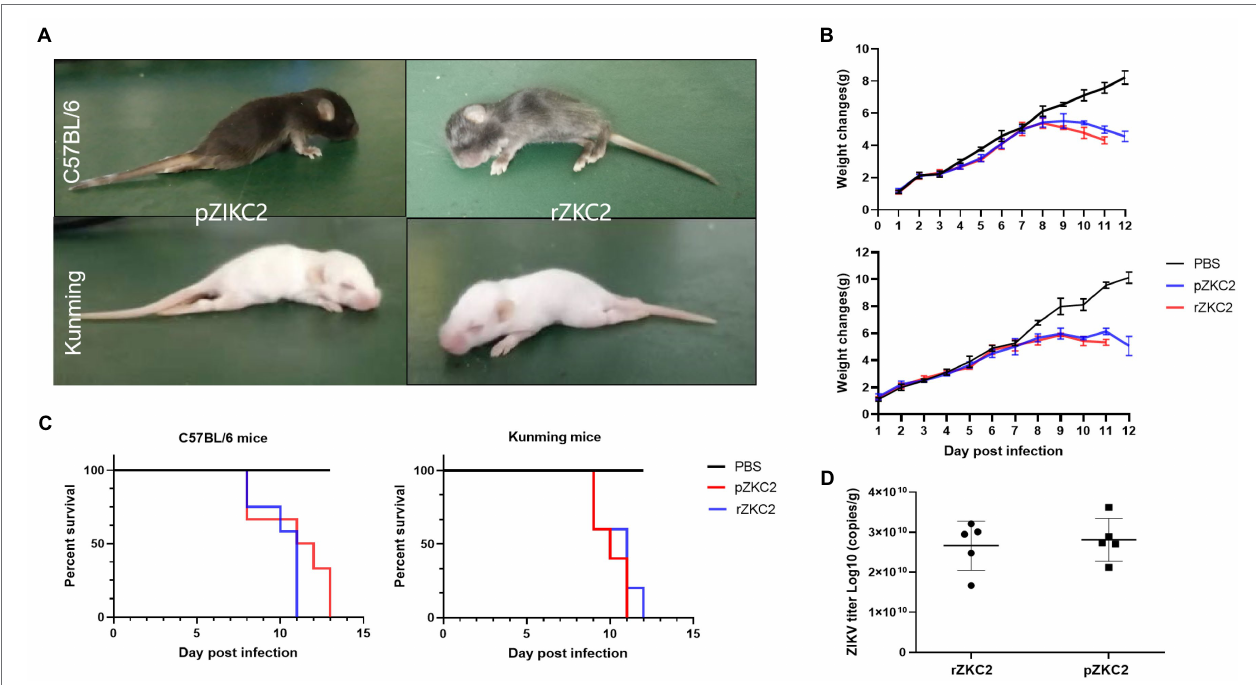
FIGURE 5 | In vivo tests for the rZKC2 and pZKC2 in the neonatal mice. (A) Symptoms of suckling mice after infection; (B) Weight change; (C) Survival curves; and (D) Virus titer in the brains of the C57BL/6 and Kunming suckling mice infected by pZKC2 and rZKC2. The number (n) of mice used was 10 for C57BL/6 neonatal mice and n = 12 for Kunming neonatal mice. Log-rank test ( p > 0.05) was used to compare the survival curve